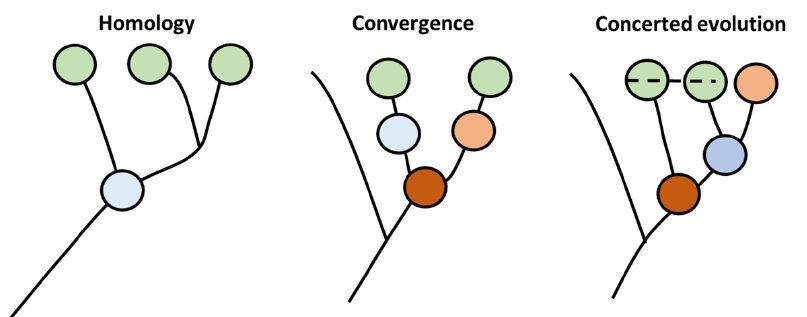
Figure 1. CoRc evolution produces novel cell types adapted from [14]. Three types of evolution patterns have been hypothesized to produce cellular diversity, namely homology, convergence, and concerted evolution. Similar color represents similar phenotype. The dotted line represent exchange of genetic material.